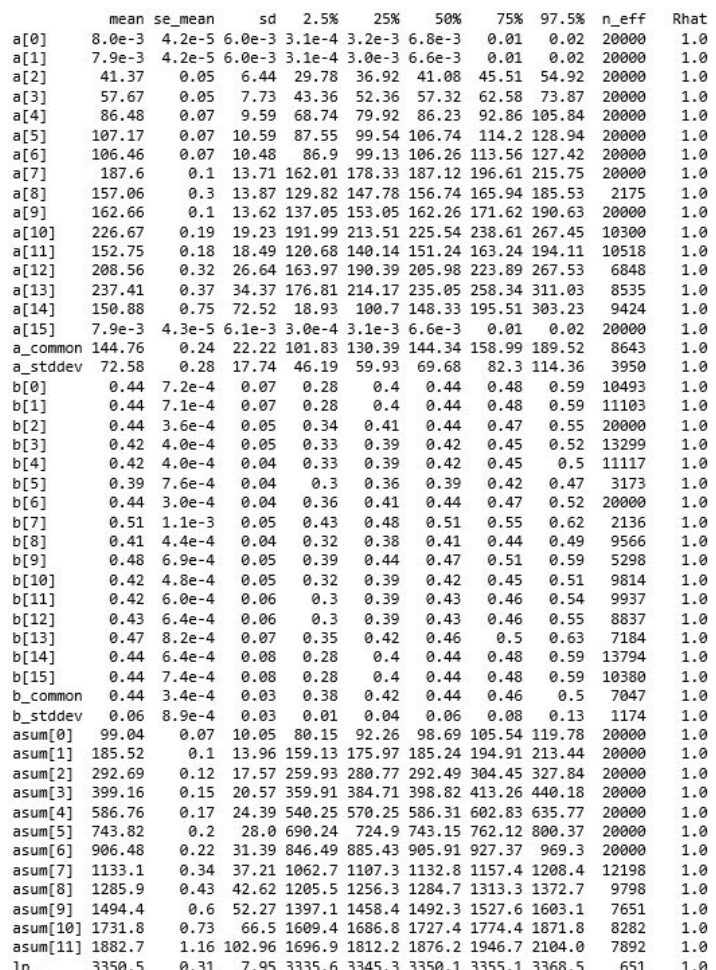
Figure 4. Fitted bugs per branch. Here, each branch is considered as a feature which are visualized with different colors in the fit.